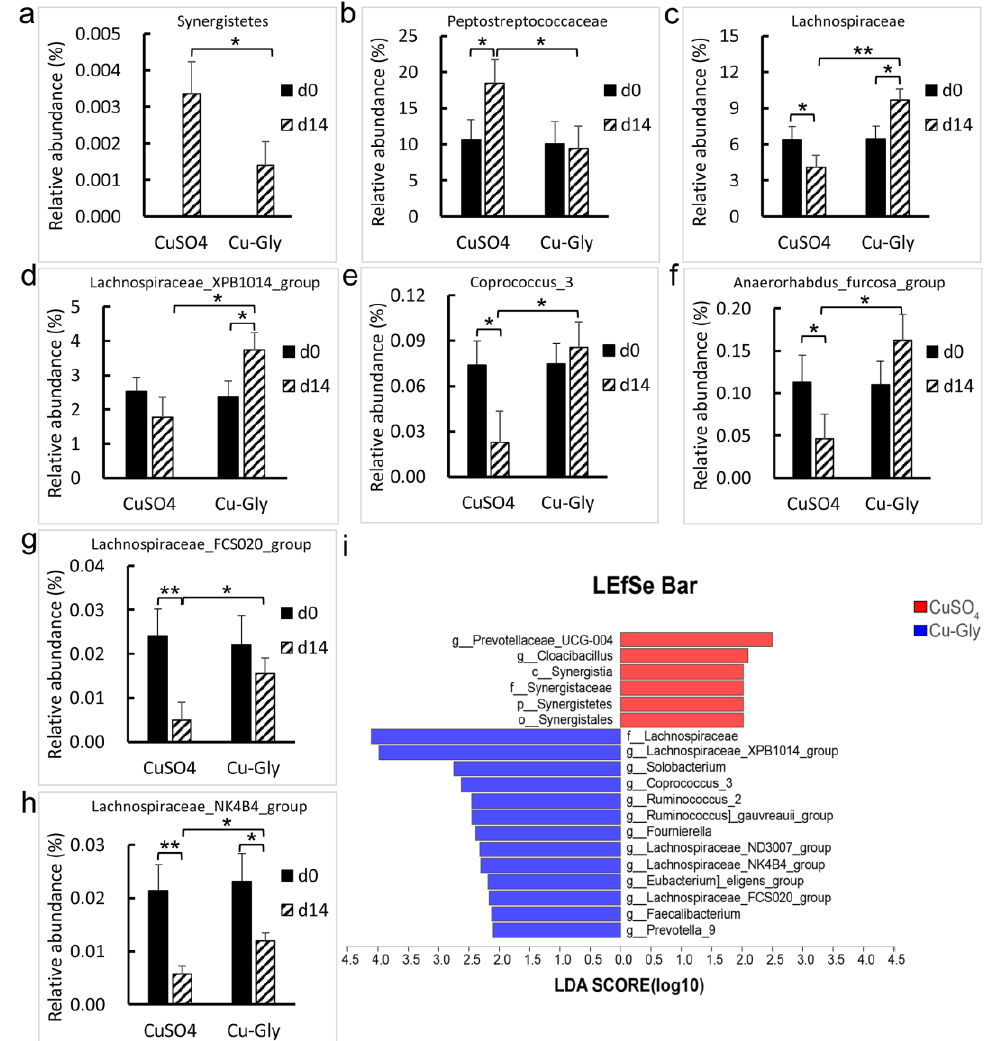
Figure 5. Effects of Cu sources on the relative abundance of bacteria in the feces of pigs. The column charts showed the changes in the relative abundance of the phylum Synergistetes ( a ), the families Peptostreptococcaceae ( b ) and Lachnosiraceae ( c ), and the genera Lachnospiraceae_XPB1014_group ( d ), Corprococcus_3 ( e ), Anaerorhabdus_furcosa_group ( f ), Lachnospiraceae_FCS020_group ( g ), and Lachnospiraceae_NK4B4_group ( h ) in the CuSO 4 and Cu-Gly groups. Only significant changes in microbiota abundance were presented. Data present mean values ± standard errors. * represents a significant difference at p < 0.05, and ** represents a significant difference at p < 0.01. ( i ) A non-parametric factorial Kruskal–Wallis (KW) sum-rank test and linear discriminant analysis (LDA) were performed to discriminate the microbial community that contributed to the significant difference in the CuSO 4 and Cu-Gly groups. The bar represents thelLinear discriminant analysis effect size (LEfSe). n =